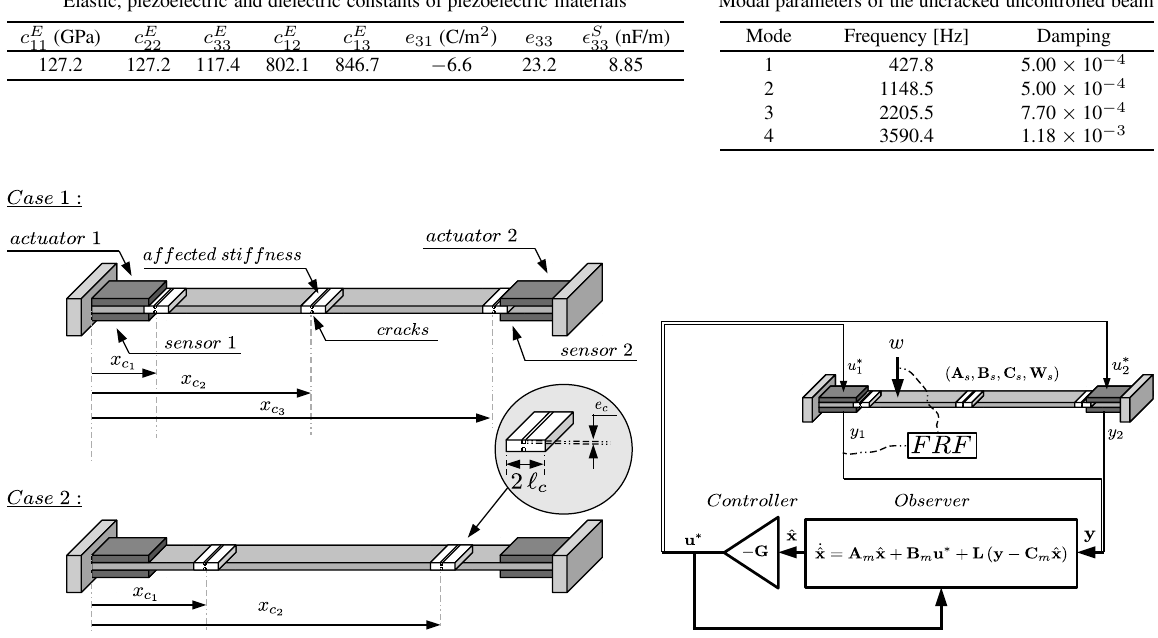
Fig. 2. Multi-cracked composite beam in case 1 and 2. Fig. 3. Controlled multi-cracked composite